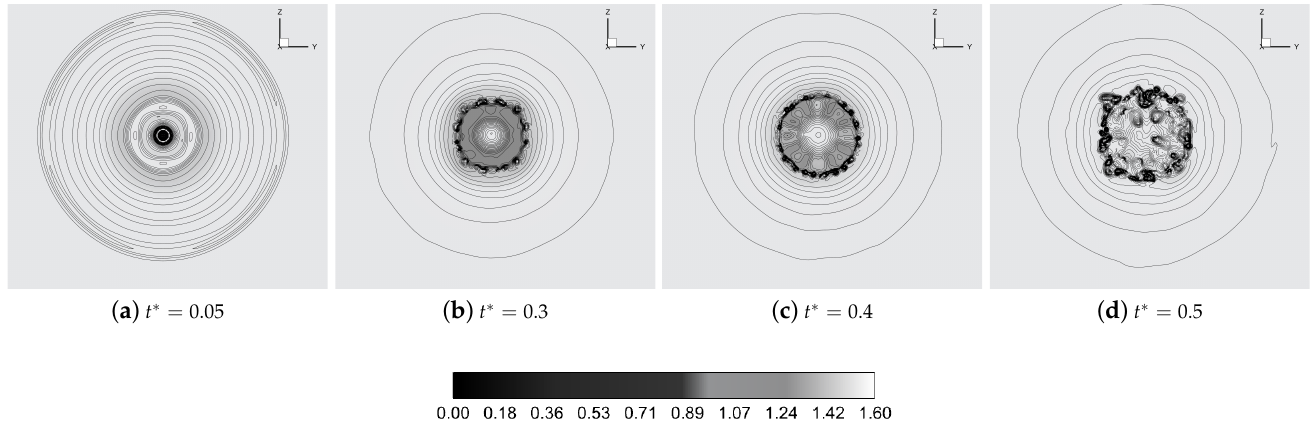
Figure 4. Predicted droplet morphology ( top ) compared to experimental images by Theofanous and co-workers [8] ( bottom ), at six typical time instants. The airflow is from right to left.